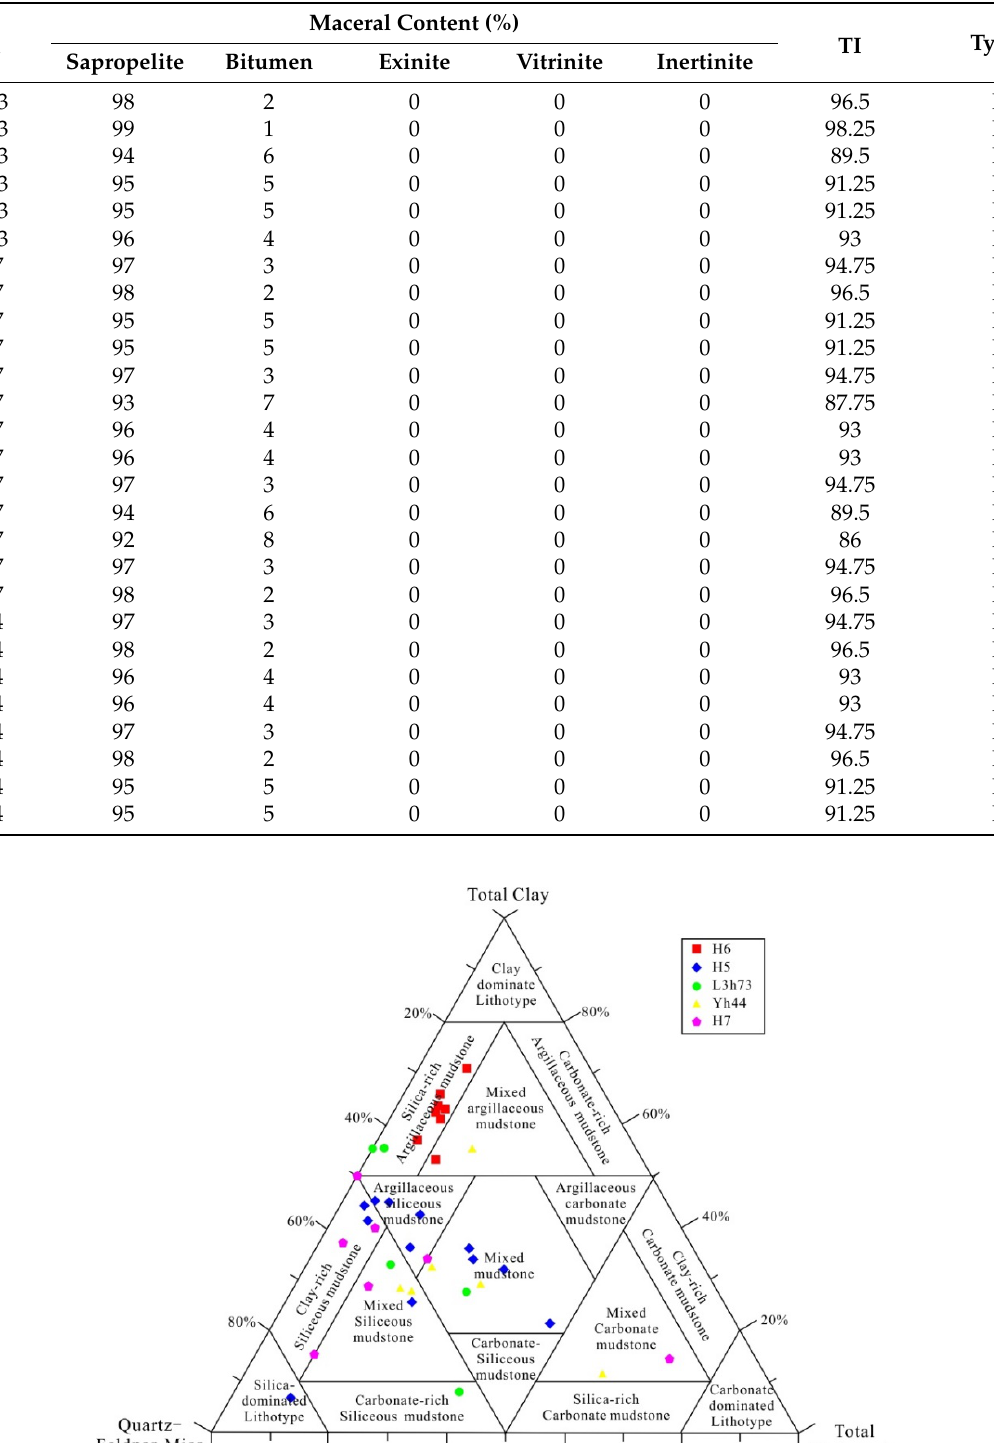
Table 1. Organic macerals and TI index of shale in the Longmaxi Formation in the study area.